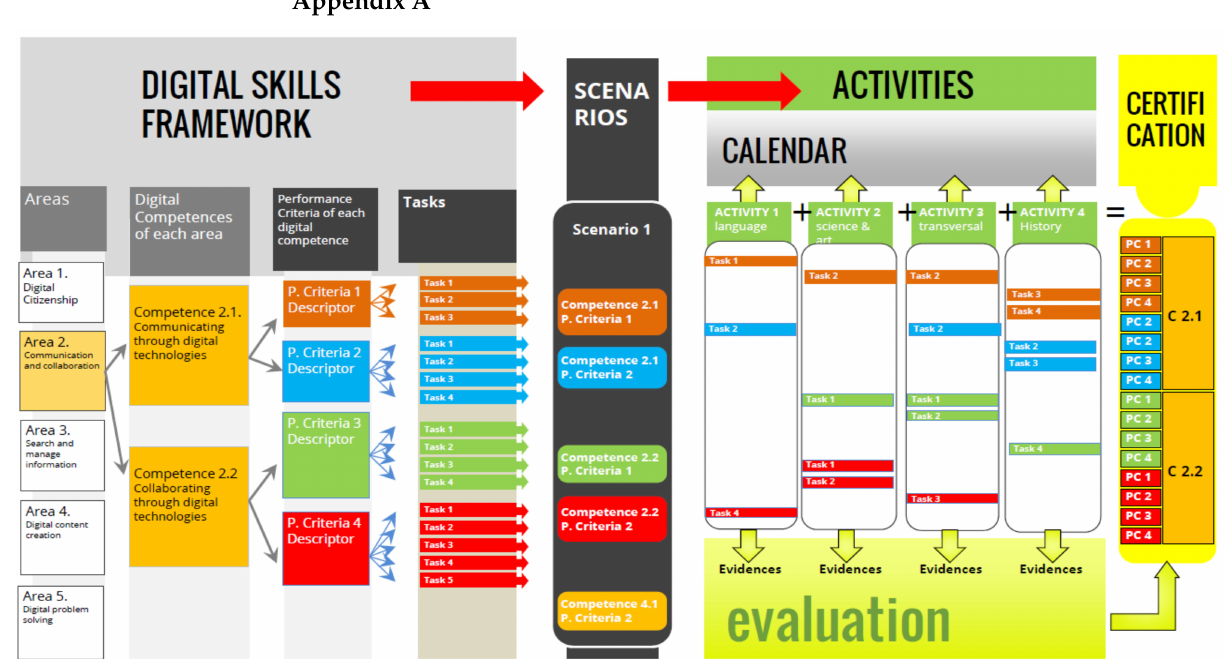
Figure A1. An overview of a CRISS DC certification process.